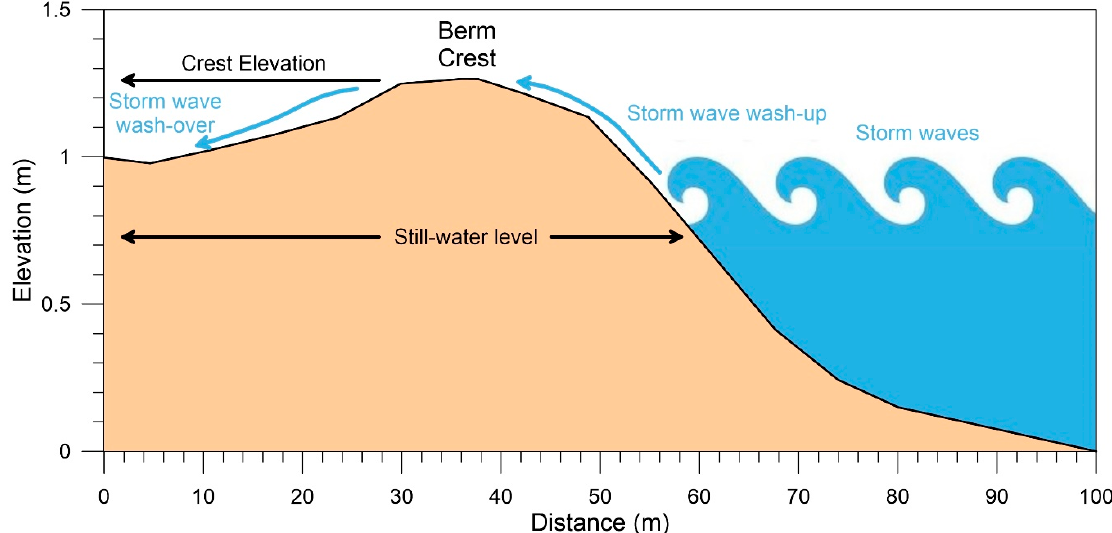
Figure 4. Schematic illustrating how the elevation of the shoreline berm crest relates to lake level. The still-water level is located near the center of the beach face; however, large storm waves wash up the beach face, pushing coarse sand and gravel upward to build the prominent storm berm. Particularly large waves may wash over the berm crest. The measured elevation of the berm crest, therefore, is an over-estimate of the still-water level for the lake that built each berm. In light of this, the midpoint of the beach face was considered to represent the former still-water